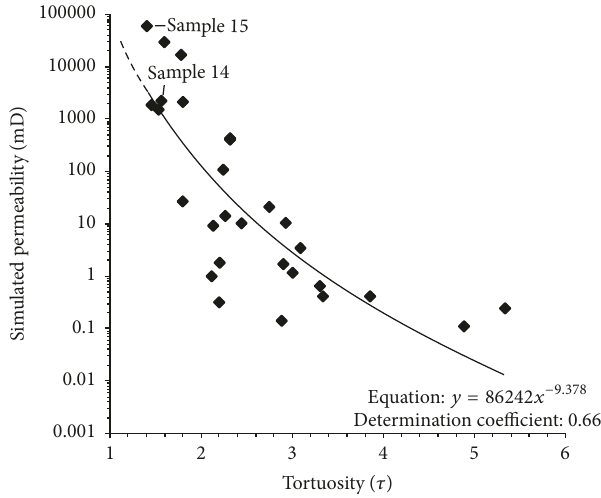
Figure 13: Tortuosity-simulated permeability cross-plot. A moder- ate power-law relationship is observed between these parameters.